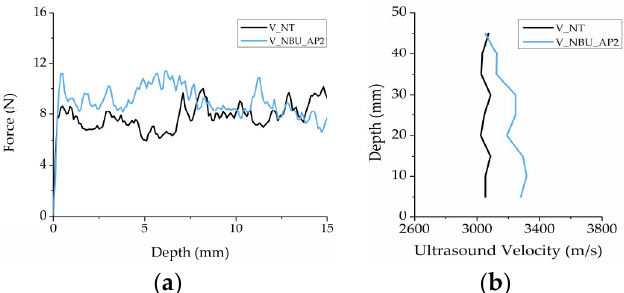
Figure 13. Vicenza stone treated with NBU applied through absorption by capillarity AP2 (V_NBU_AP2): ( a ) drilling resistance and ( b ) UPV profile. NT: Untreated